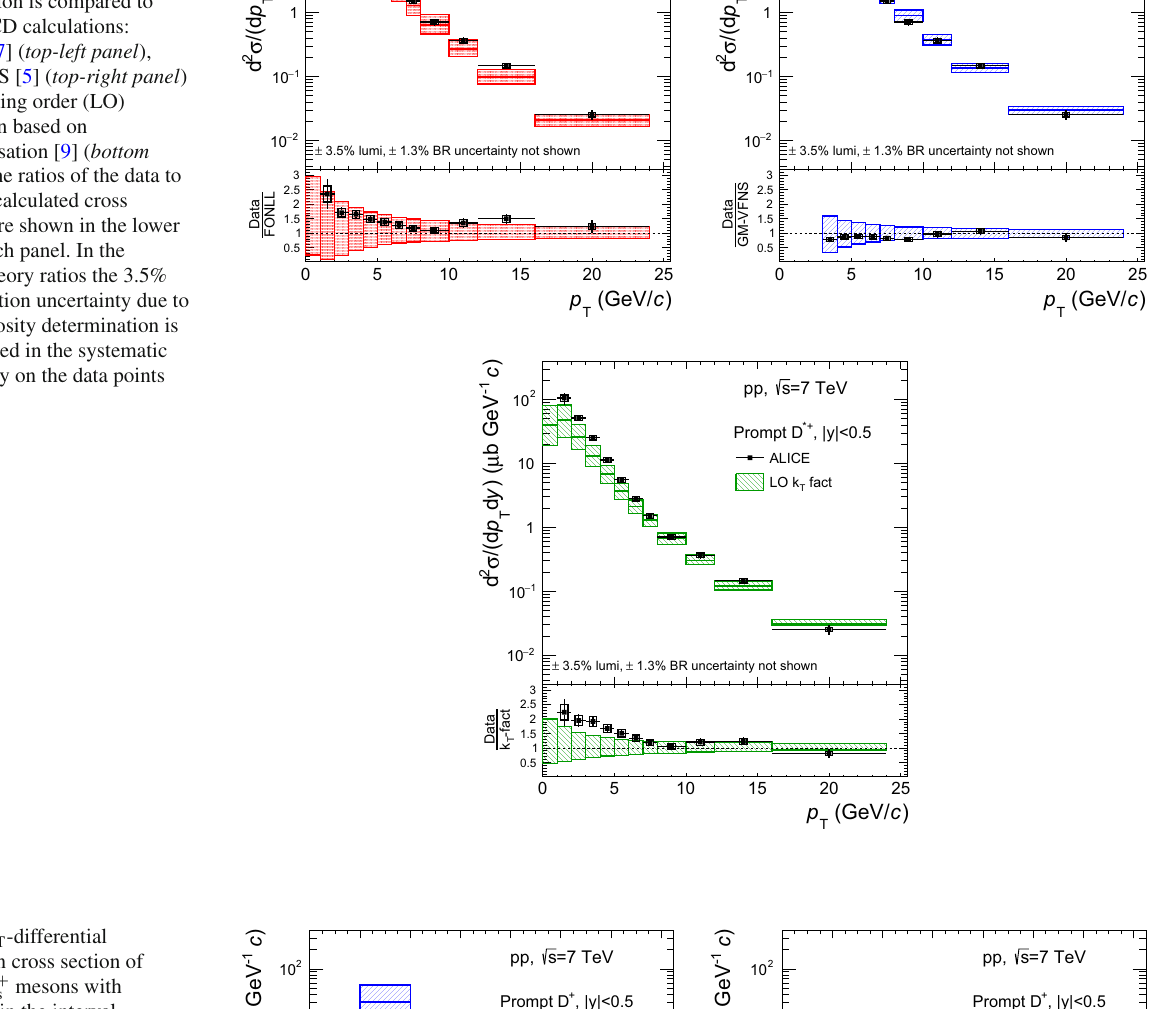
Fig. 7 p T -differential production cross section of prompt D + s mesons with | y | < 0 . 5 in the interval 2 < p T < 12 GeV / c , in pp √ s = 7 TeV. The collisions at cross section is compared to two pQCD calculations: GM-VFNS [5] ( left panel ) and a leading order (LO) calculation based on k T -factorisation [9] ( right panel ). The ratios of the data to the calculated cross sections are shown in the lower part of each panel. In the data-to-theory ratios the 3.5% normalisation uncertainty due to the luminosity determination is not included in the systematic uncertainty on the data